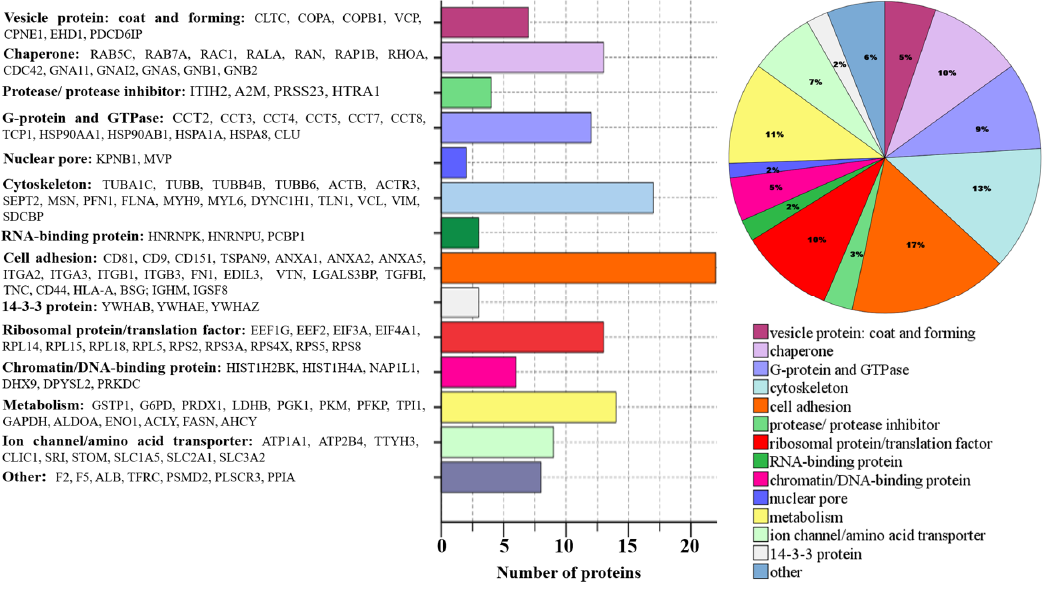
Figure 5. Molecular functions of 133 common proteins (the corresponding gene names are given) secreted by 5 glioma cell lines.